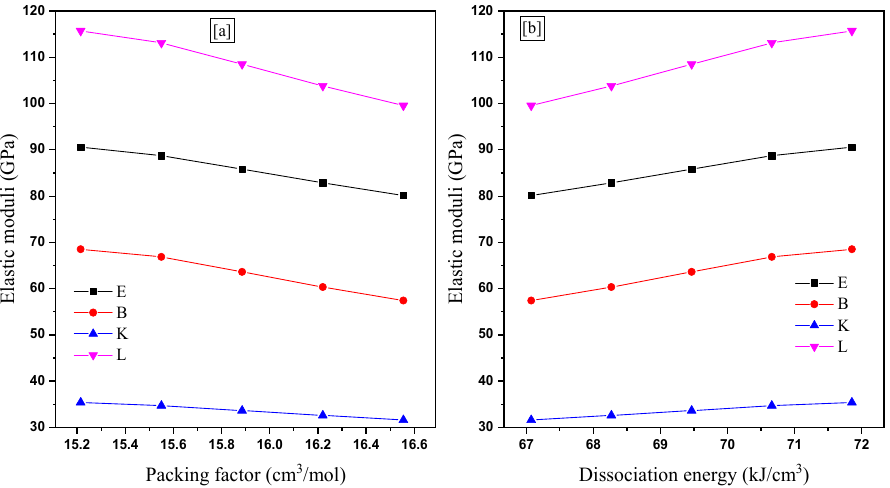
Figure 4. The elastic moduli (Y, B, K, and L) versus ( a ) packing factor and ( b ) dissociation energy. The hardness (GPa) is considered an important parameter for shielding materials such as concretes and bricks, but in the case of small-scale materials, such as glass, the term microhardness (H, GPa) is applied. It is used to describe the load which the material can stand over without deformations. The TABLi glasses’ microhardness presented in Figure 5 was enhanced from 4.900 to 5.199 GPa by increasing the Li 2 O in the content. This can contribute to the increase in compactness of the material and decrease the r (B-B), r (Li- Li), and r (Te-Te) by increasing the Li ions in the glass network (Table 2). The Poisson ratio ( σ ) describes the expansion ratio of the investigated TABLi glasses in the direction vertical to the loader direction. Figure 5 showed that the σ values also increase from 0.267 to 0.280 with the replacement of TeO 2 with Li 2 O content. Softening temperature (T g , °C) was reported for the TABLi glasses based on the EM predicted previously (see Figure 6). It is clear that the T g ’s values increased from 464.9 to 525.8 °C. The increase detected in T g values is due to the replacement of TeO 2 with a lower melting point (MP) by a higher (i.e., Li 2 O), where the MP TeO2 = 733 °C and MP Li2O = 1570 °C.